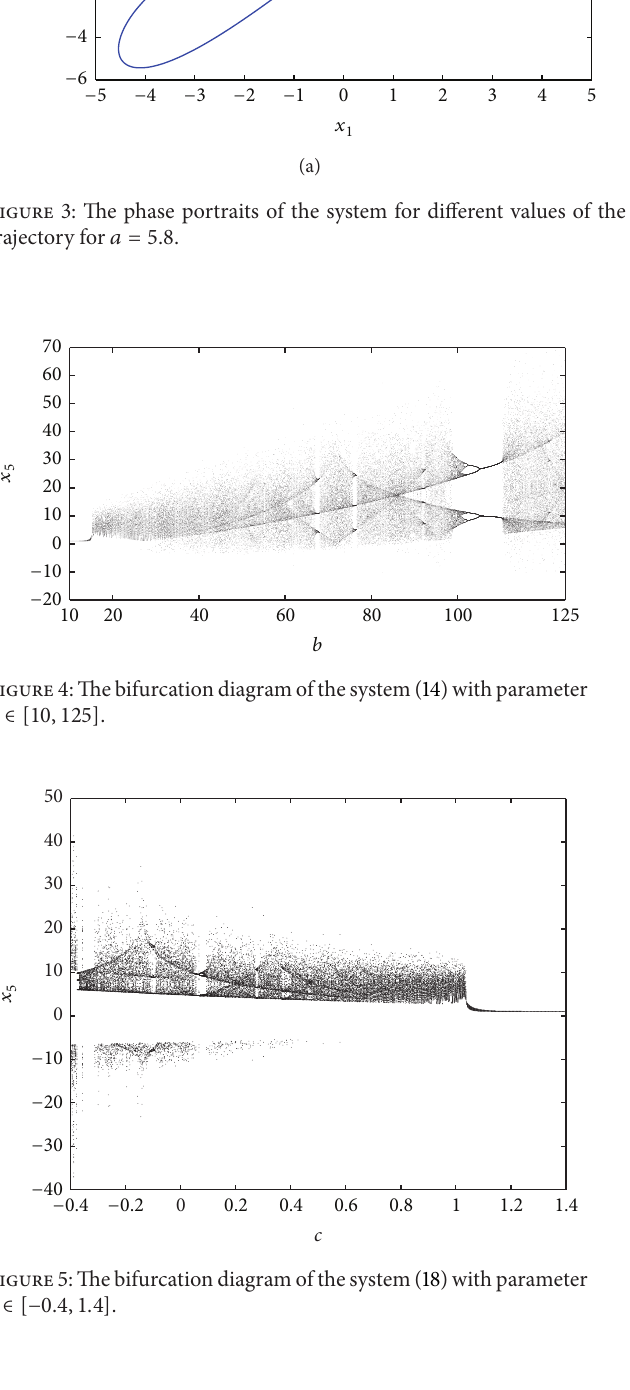
Multiplying the above equation left by 𝜉 𝐻 P , we obtain